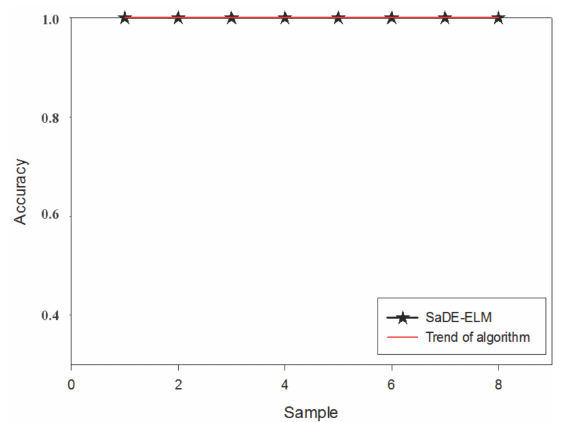
Figure 14. SaDE-ELM algorithm for marine fuel system fault